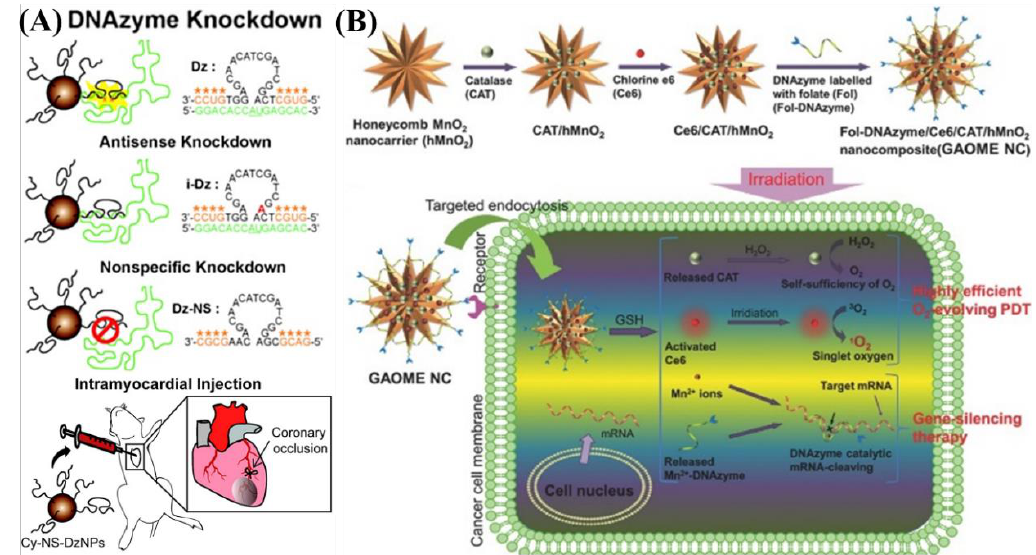
Figure 9. Representative examples of in vivo gene regulation based on RNA-cleaving DNAzymes.